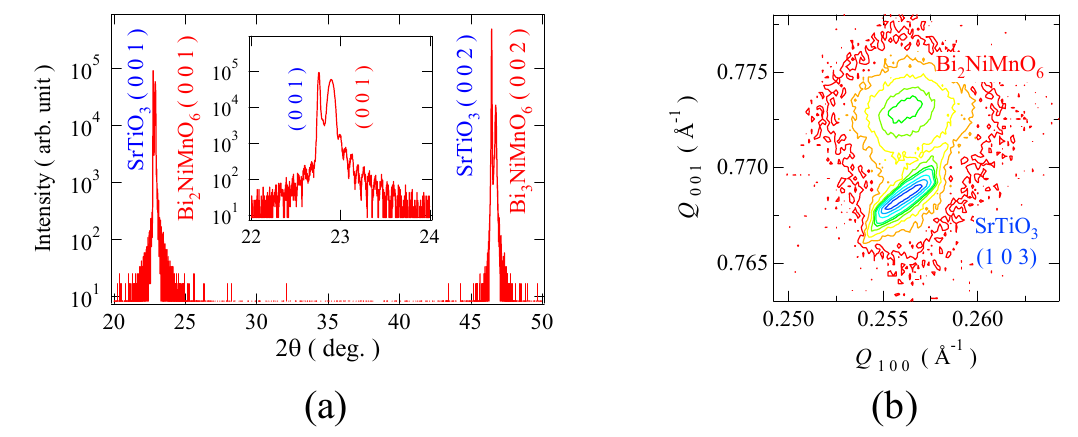
Figure 5. (a) X-ray diffraction patterns of Bi NiMnO thin film grown on SrTiO 2 6 substrate; (b) Logarithmic intensity reciprocal space map around (1 0 3) reflection of the substrate peaks, Bragg reflections of the perovskite thin film. In addition to the SrTiO 3 Bi NiMnO thin film are clearly seen and the results also confirm the epitaxial growth of 2 6 the film on the substrate